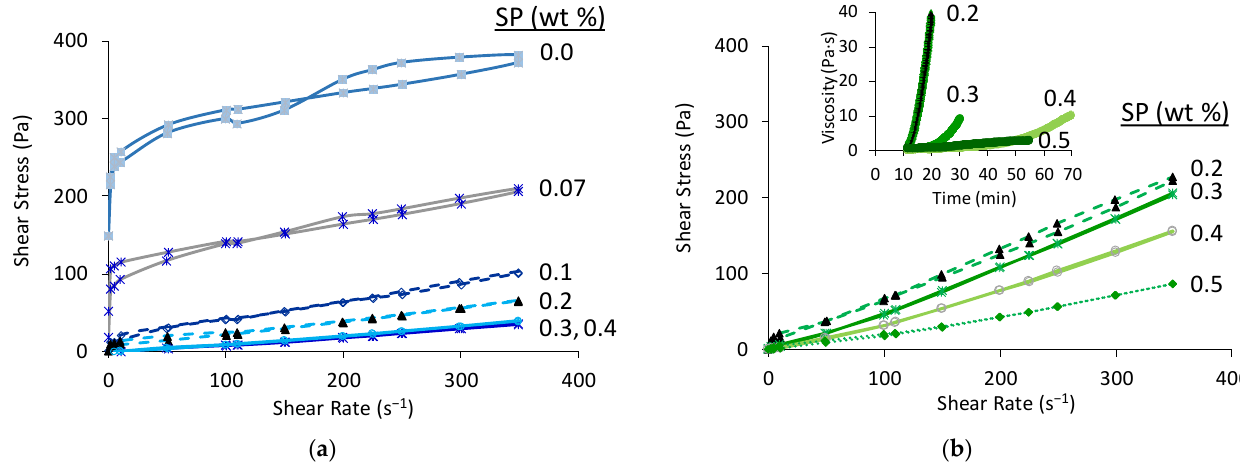
Figure 1. Flow curves of ( a ) st-BYF and ( b ) B-BYF pastes prepared at w/c = 0.40 and different superplasticiser (SP) contents. Inset of ( b ) shows the evolution of the viscosity with time of B-BYF pastes (w/c = 0.40) and different amounts of SP at a shear rate of 5 s −1 . Numbers close to each curve stand for the amount of SP (wt %) of active matter referred to cement content.